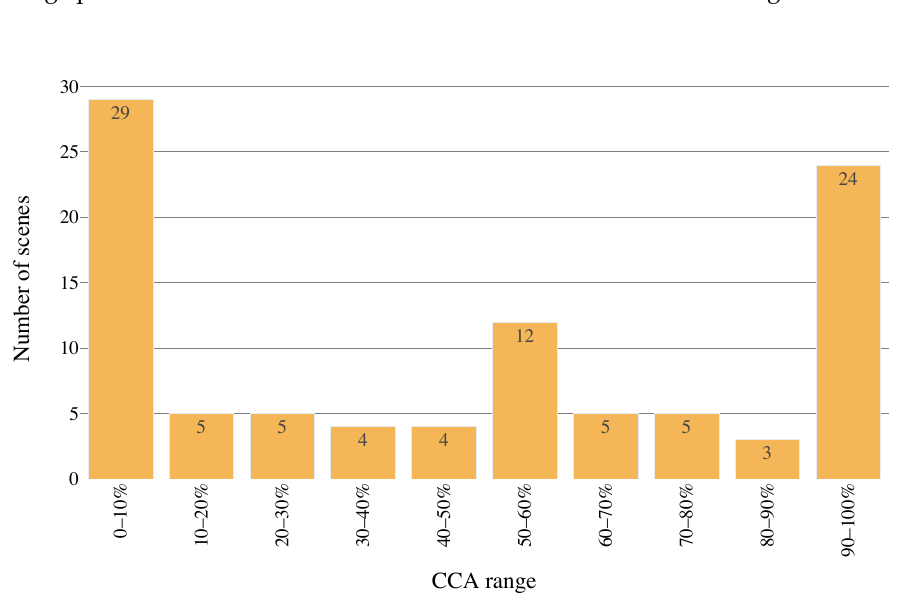
Figure 2. Distribution of the L8 biome dataset scenes CCA values